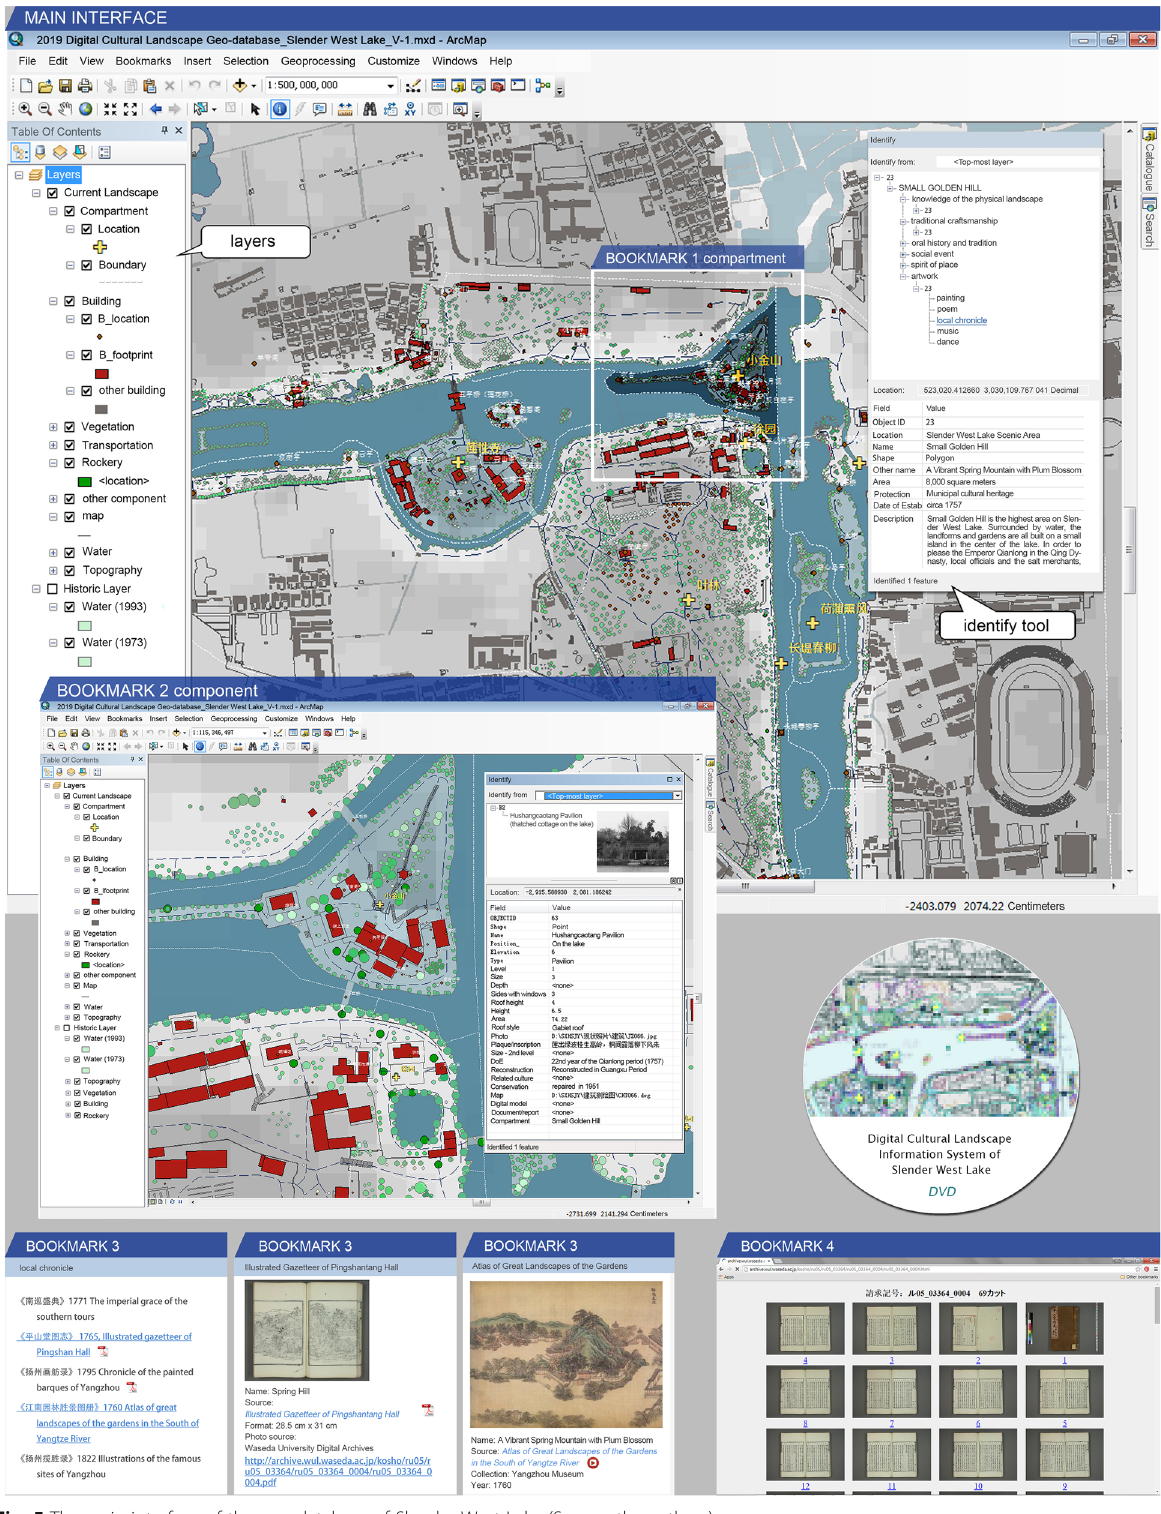
Fig. 5 The main interface of the geo-database of Slender West Lake (Source: the